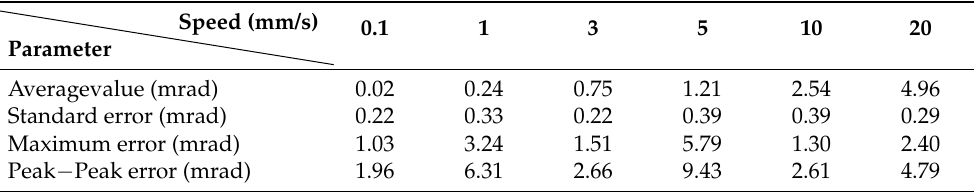
Table 1. Phase increment errors in phase resolution algorithms with dynamic filters at different